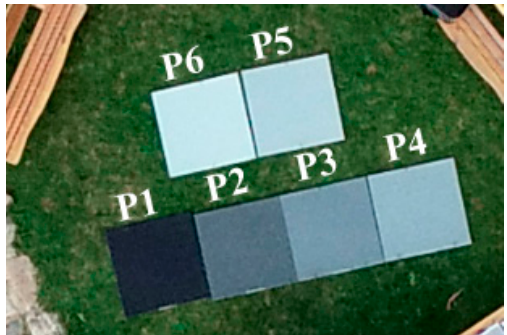
Figure 1. Localization of study area (left image based on Reference [41])